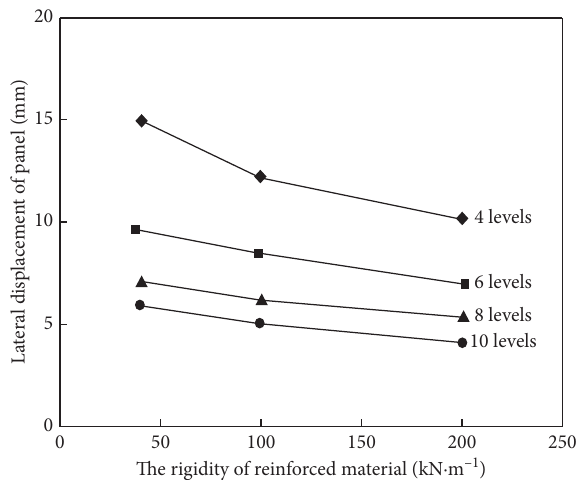
Figure 8: Change of lateral displacement of panel with rein- forcement stiffness.